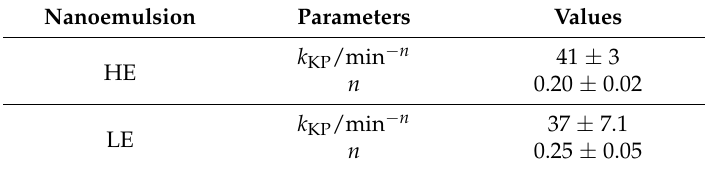
Table 3. Fitting parameters of the drug release kinetics to the Korsmeyer-Peppas model.